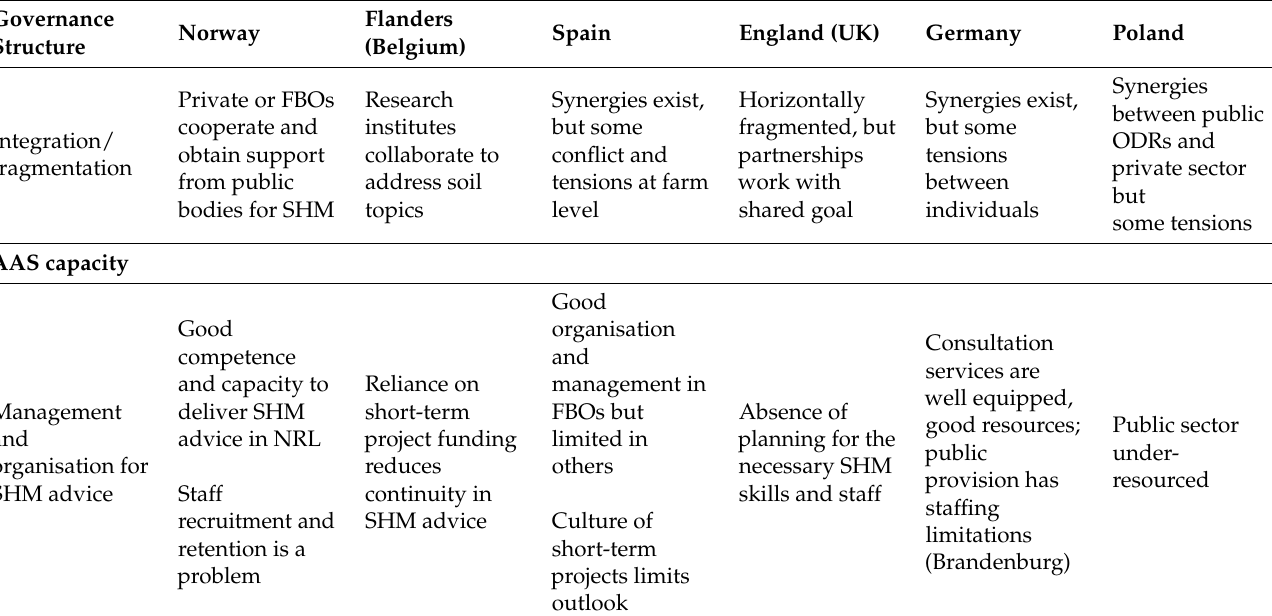
Table 3. Summary of AAS characteristics for case